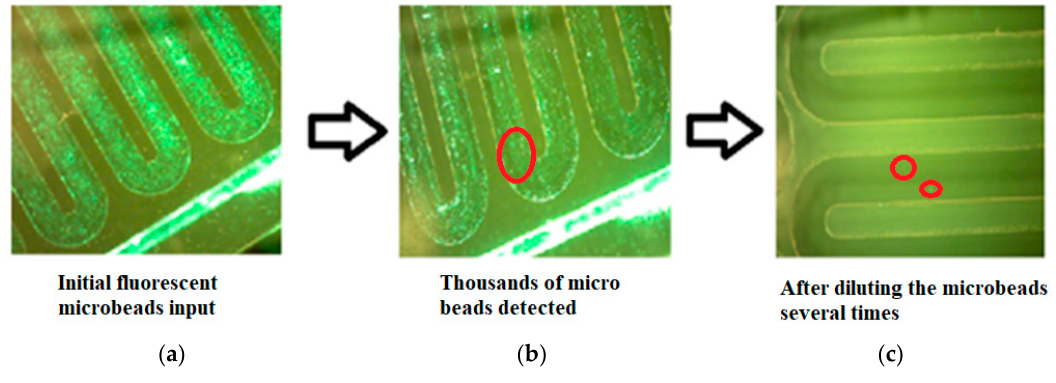
Figure 5. Diluting process images illustrated by ( a ), ( b ) and ( c ) .